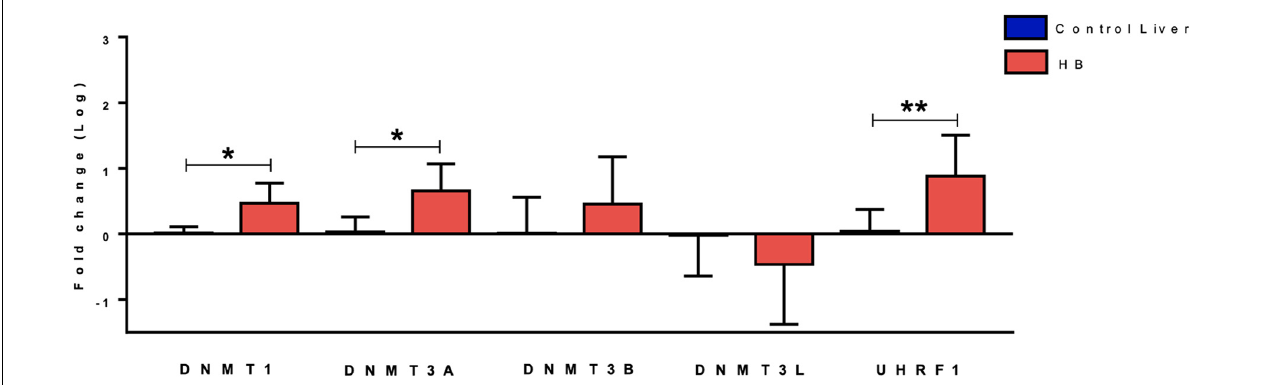
FIGURE 1 | Expression analysis of DNA methylation genes in hepatoblastomas. DNMT1, DNMT3A and UHRF1 upregulation in 19 tumor samples compared with eight non-tumoral liver samples as evidenced by RT-qPCR. Control Liver: non-tumoral liver tissue samples; HB: hepatoblastoma samples. Endogenous gene: 18S rRNA . The Kruskal Wallis post hoc Dunn test with Bonferroni correction was used for statistical analysis. ∗ p -value < 0.05, ∗∗ p -value < 0.01.